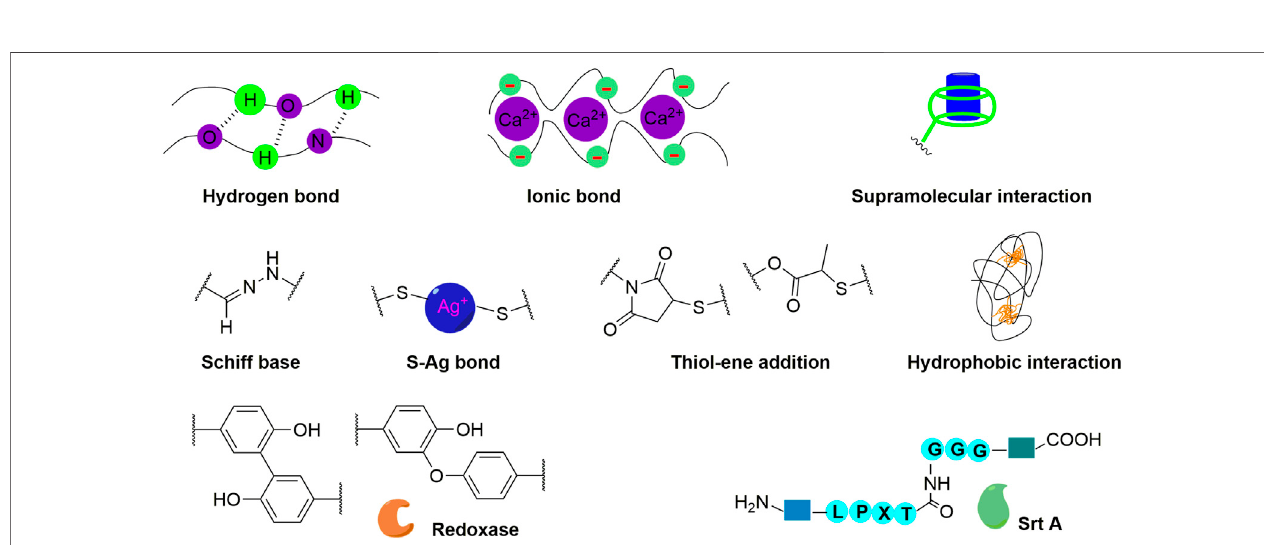
FIGURE 2 | Chemical structures of representative (A) polysaccharides, (B) proteins and (C) synthetic polymers as hydrogel scaffolds.